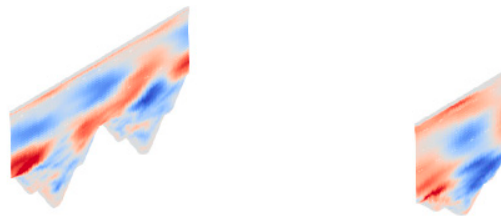
Figure 6. The mode variance distribution for the first 1000 modes and the first eight POD modes of the stream-wise velocity corresponding to the three levels of roughness height.